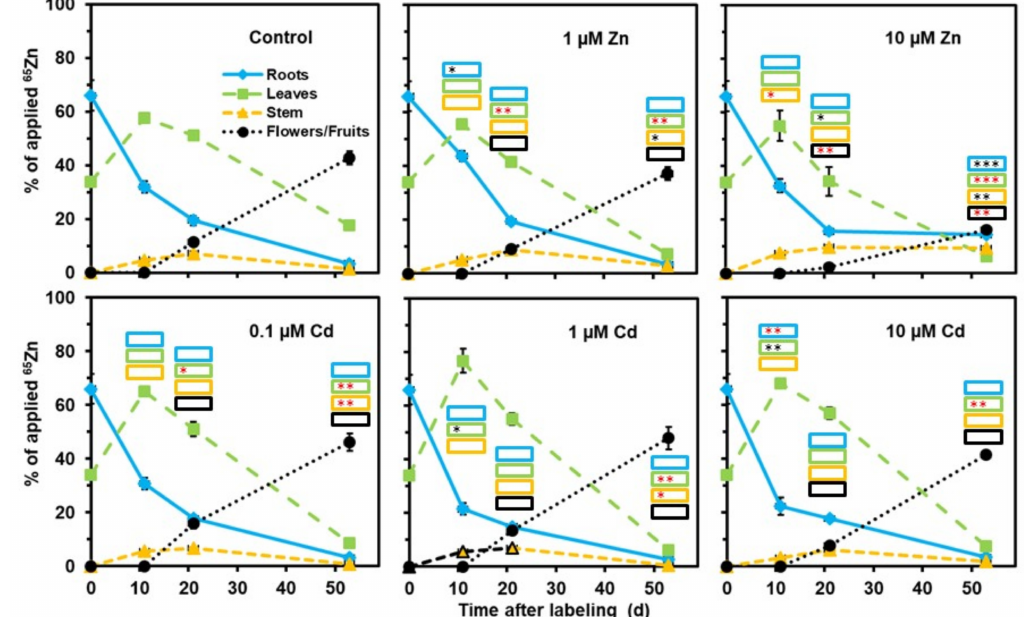
Figure 3. Influence of elevated cadmium (1 µ M Cd and 10 µ M Cd) or zinc (1 µ M Zn and 10 µ M Zn) concentrations in the nutrient medium on the redistribution of 65 Zn. The plants were labeled with 65 Zn in standard nutrient medium for 3 d before transferring them to the media indicated (day 0). Means + SE of four replicates are shown. Significantly higher (*, **, ***) and lower (*, **, ***) values than in control plants on the P = 0.05 (*, *), P = 0.01 (**, **), and P = 0.001 (***, ***) level are indicated in the insets for the various plant parts collected on day 11, day 21, and day 53 (Student’s